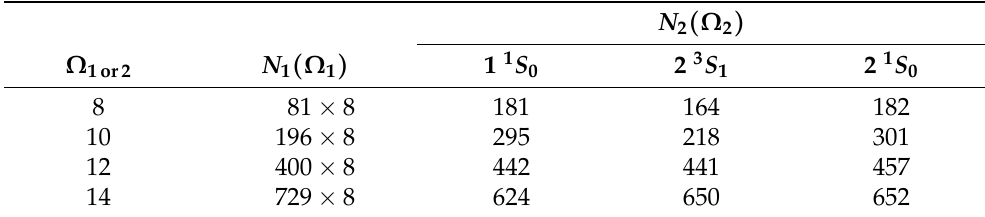
Table 3. Number of terms N 1 ( Ω 1 ) and N 2 ( Ω 2 ) in the basis sets. The factor 8 for N 1 ( Ω 1 ) accounts for the sum over partial waves up to (cid:96) =